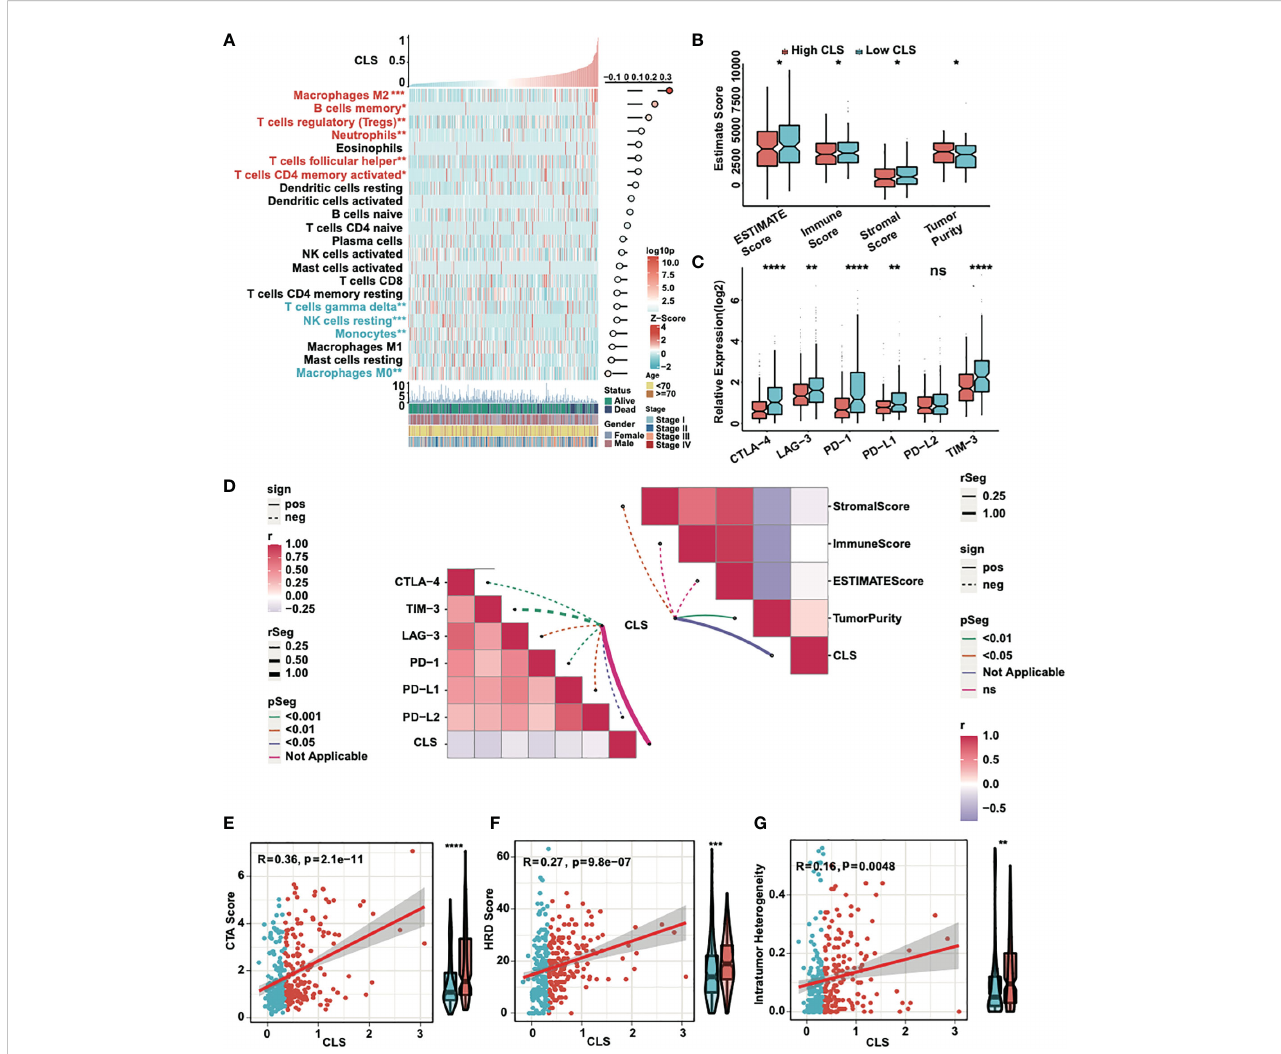
FIGURE 5 Immune analyses of the CLS model. (A) The expression and correlation between the TICs and CLS. (B) The ESTIMATE score (including immune and stromal score) and tumor purity in high and low CLS samples. (C) The relative expression of six immune checkpoints in high and low CLS samples. (D) The correlation between CLS and immune checkpoints/ESTIMATE. (E) The correlation between the CTA score and the CLS, and the level of CTA score in high and low CLS samples. (F) The correlation between the HRD score and the CLS, and the level of HRD score in high and low CLS samples. (G) The correlation between the intratumor heterogeneity and the CLS, and the level of the intratumor heterogeneity in high and low CLS samples. *P-value < 0.05, **P-value < 0.01, ***P-value < 0.001, ****P-value < 0.0001. ns, not signi fi